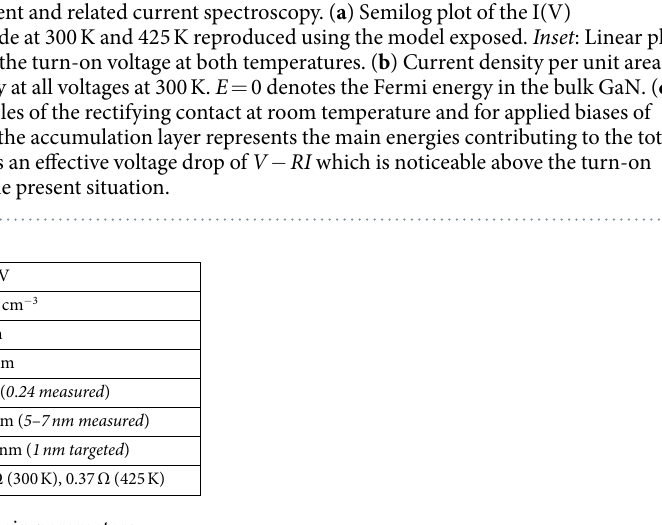
Table 2. Recessed anode diode main